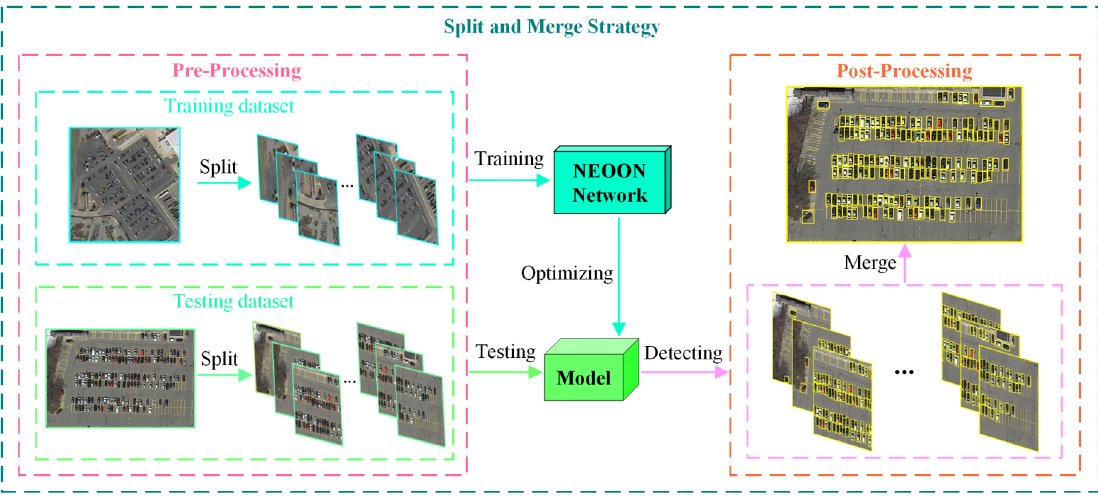
Figure 9. Split and merge strategy. We tend to split the images into several square chips and each chip is detected by the network separately to produce a single result. Finally, all the results are merged into a large image with the same size as the original